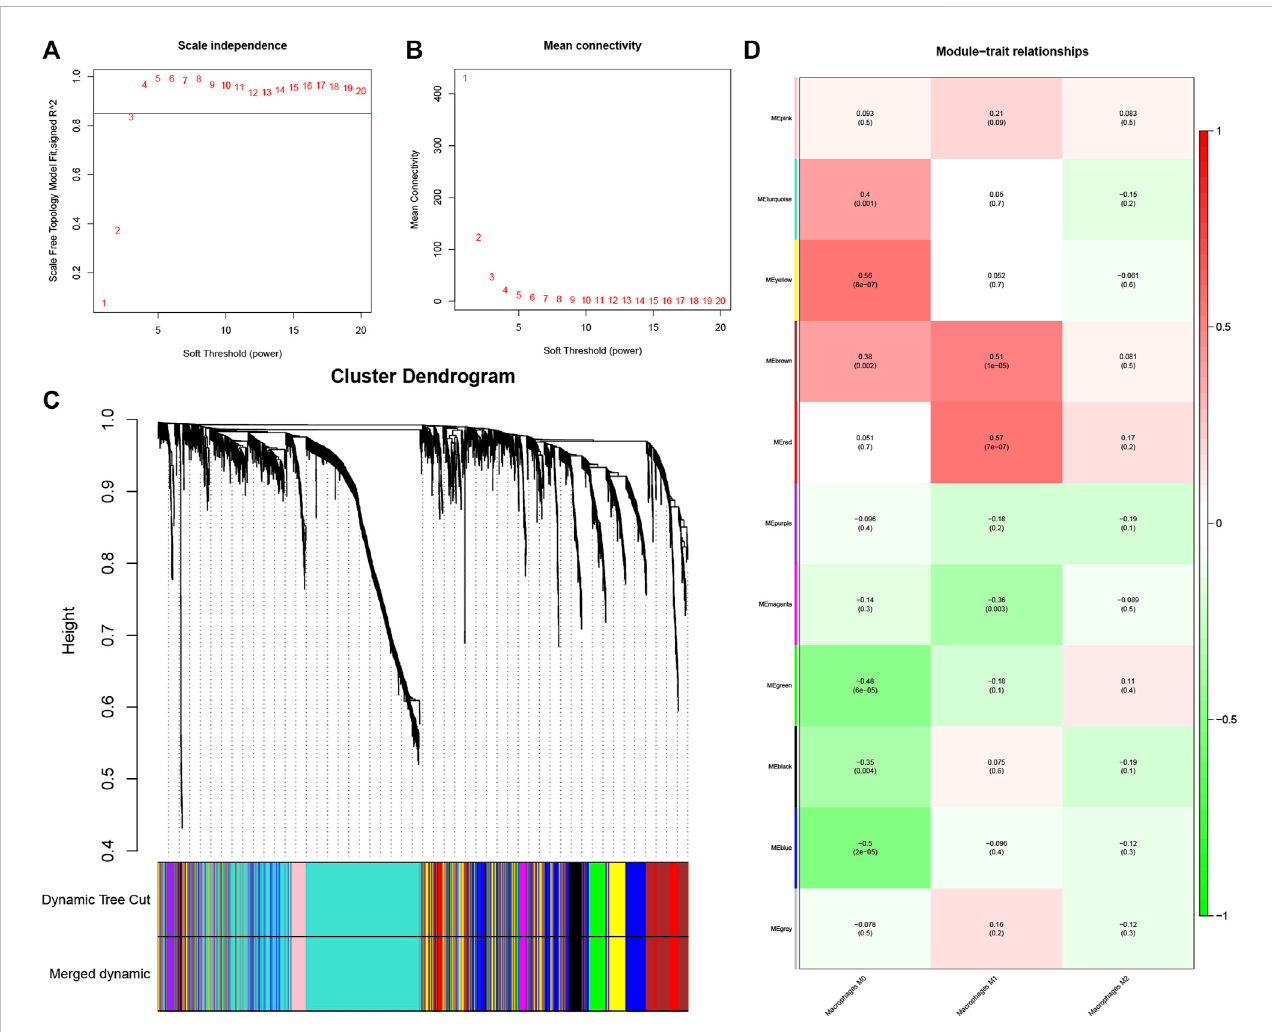
FIGURE 2 Determination of hub modules in TB. (A) Identi fi cation of the scale independence index of the 1 – 20 soft threshold power ( β = 4). (B) Veri fi cation of the mean connectivity of 1 – 20 soft threshold power. (C) Hierarchical clustering divided genes into distinct modules that presented as different colors. (D) Heatmap presents relation of module eigengenes with macrophages M1 in fi